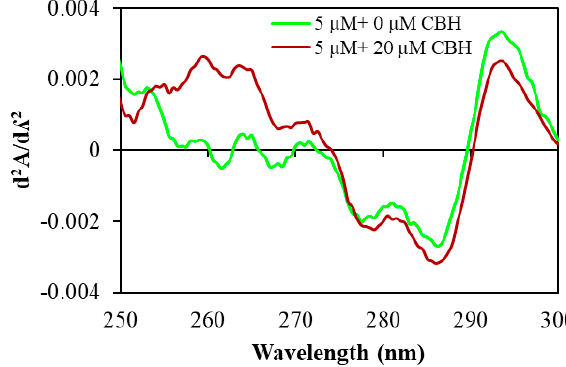
Figure 3. Second derivative absorption spectra of human serum albumin (HSA) in the absence and presence (20 μ M) of CBH at pH 7.4 and temperature 25 °C.